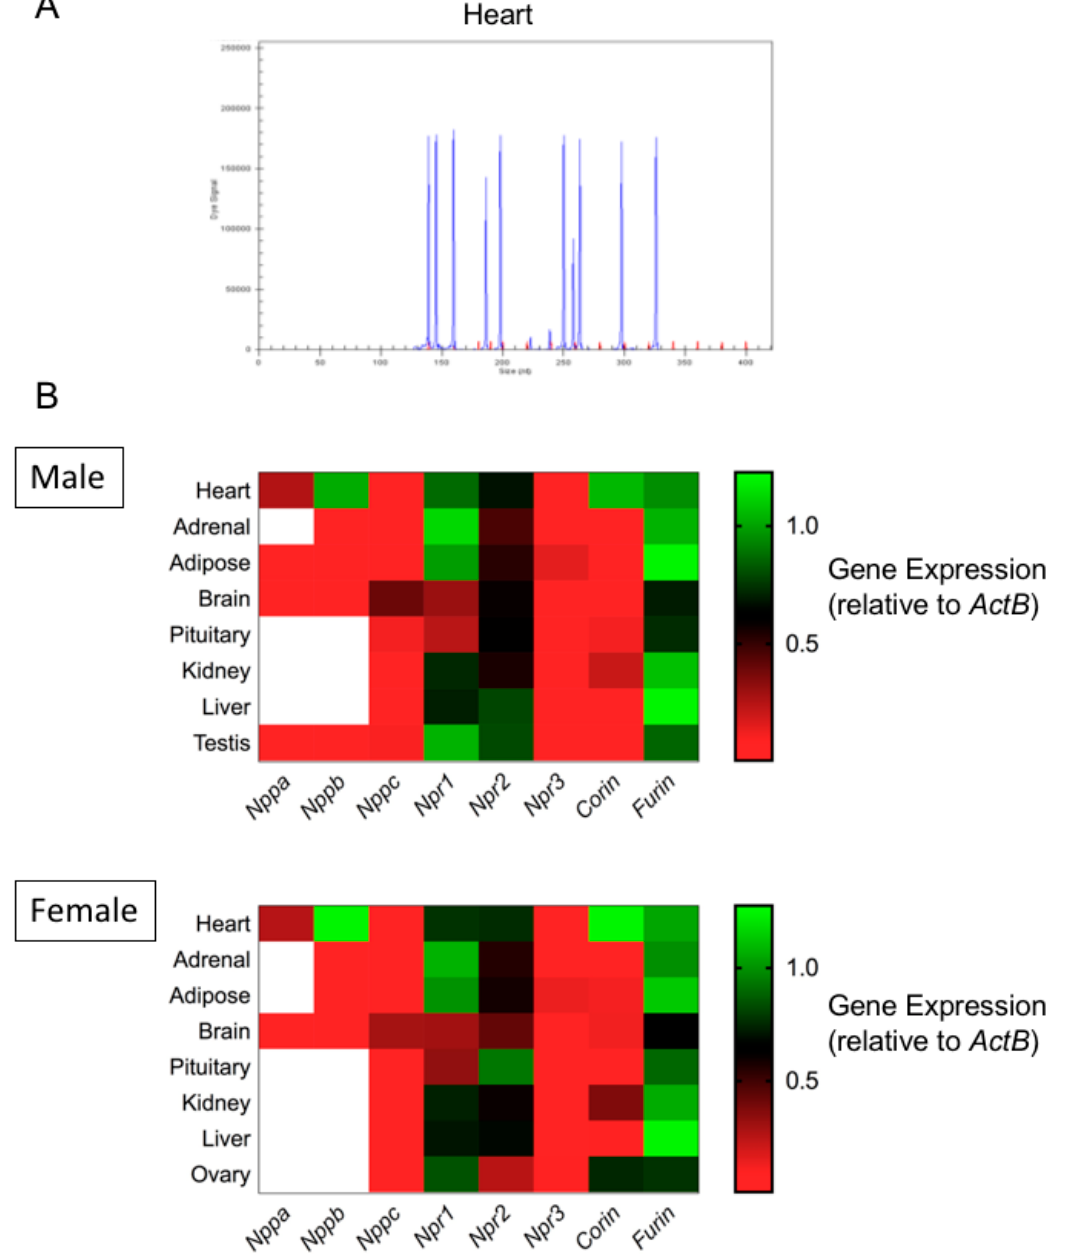
Figure 1. Expression profiling of the natriuretic peptide system in primary mouse endocrine tissues. ( A ) Murine mRNA sequences obtained from NCBI Nucleotide (https: // www.ncbi.nlm.nih.gov / nuccore), were imported into express Designer Software (Beckman Coulter), from which multiplex primers were designed using the following parameters: maximum PCR product = 300 nt, minimum PCR product = 100 nt, minimum separation size = 7 nt. Multiplex PCR reactions were performed, using specific primers for Nppa , Nppb , Nppc , Npr1 , Npr2 , Npr3 , Furin , Corin , ActB , Gapdh and Rpl19 and an internal positive control KanR. As shown (Figure 1A), capillary gel electrophoresis was used to separate specific PCR products (blue peaks), and compared alongside the appropriate size standard (red peaks, 140–420 nt). ( B ) RNA was isolated from range of tissues from 12 week old male and female C57 / B6 mice (heart, adrenal, adipose, brain, pituitary, kidney, liver, testis and ovaries; n = 5 to 8). Data shown are means (n = 5 to 8) of relative gene expression (normalized to ActB ; red indicates low level expression, green indicates high level expression, white indicates no transcript detected).